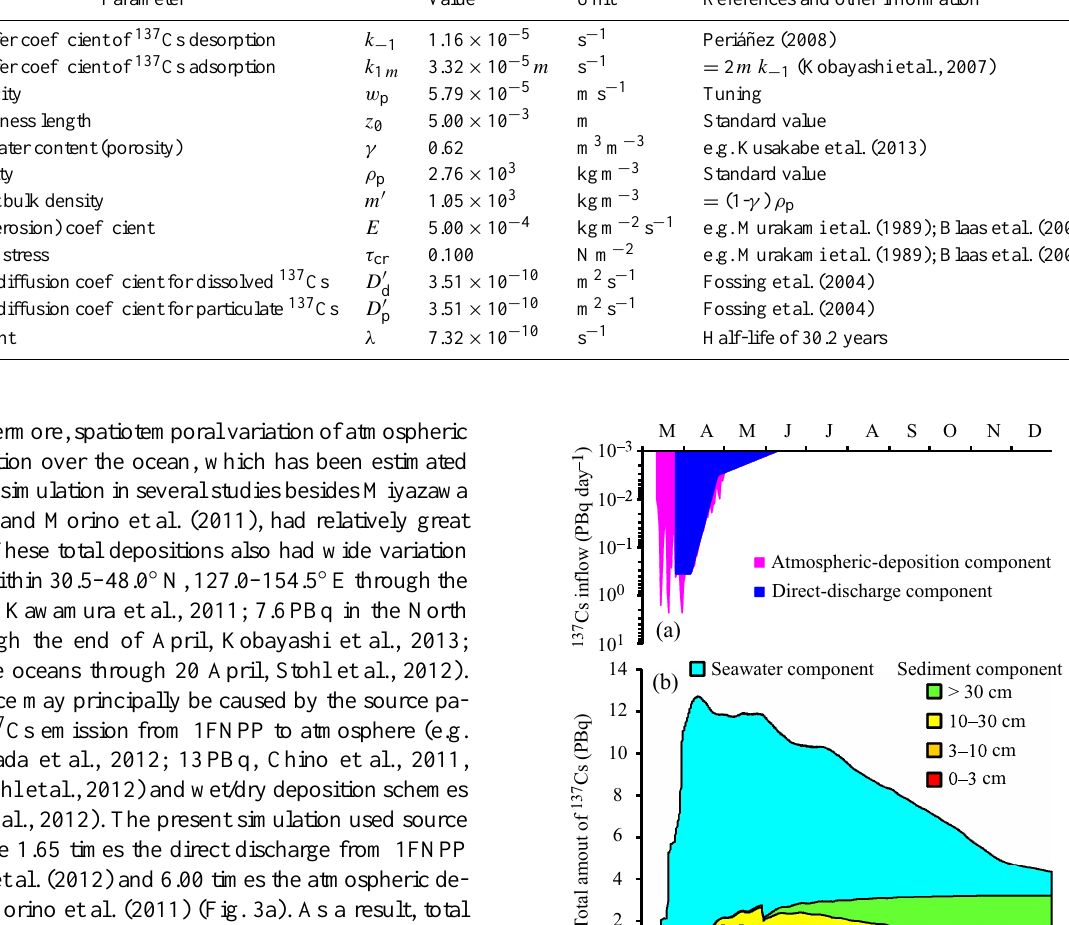
Table 1. List of parameter values used in the simulation. Parameter